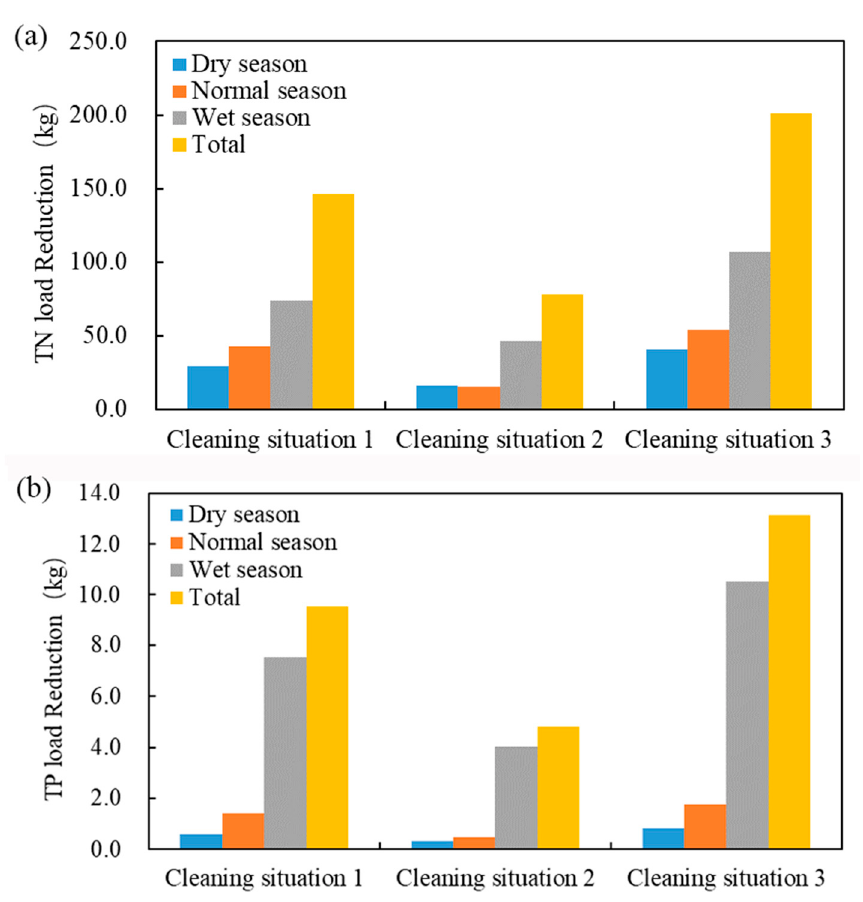
Figure 8. TN ( a ) and TP ( b ) reduction at different frequency and efficiency of road cleaning. Clean-